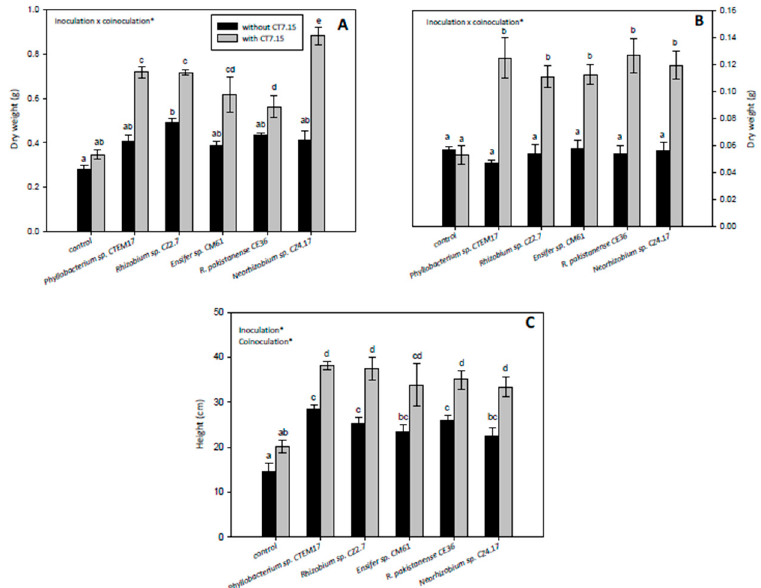
Figure 5. Aerial part dry weight ( A ), root dry weight ( B ) and plant height ( C ) of Calicotome villosa in response to inoculation with different rhizobia ( Phyllobacterium sp. CTEM17, Rhizobium sp. CZ2.7, Ensifer sp. CM61, R. pakistanense CE36 and Neorhizobium sp. CZ4.17) in absence and presence of strain CT7.15 as co-inoculant for 5 months. Values represent mean ± SE, n = 6. Different letters indicate means that are significantly different from each other (GLM, inoculation × co-inoculation; LSD test, p < 0.05). Inoculation, co-inoculation or inoculation × co-inoculation in the corner of the panels indicate main or interaction significant effects ( ∗ p < 0.001).